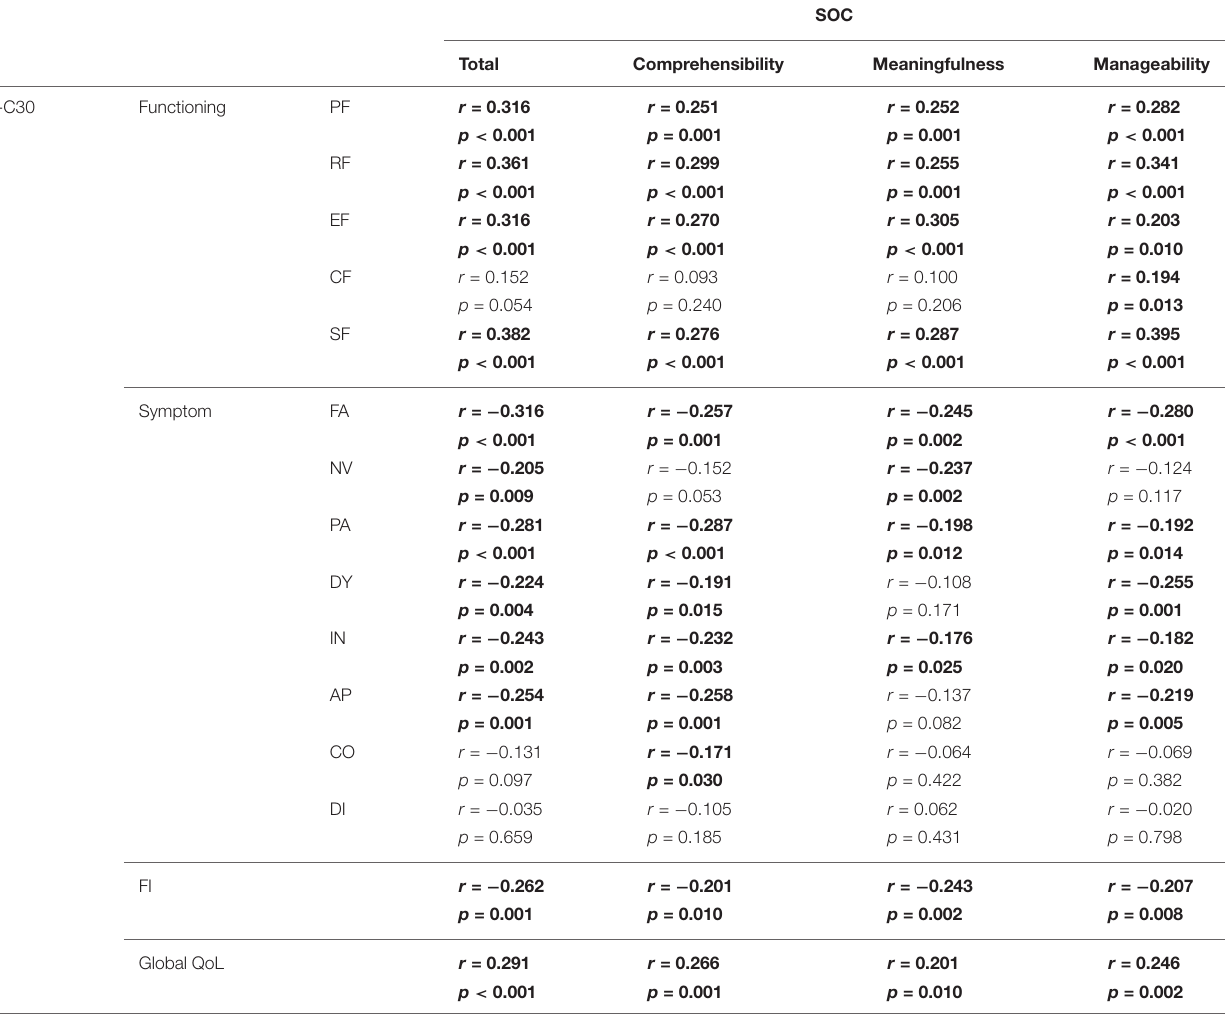
TABLE 3 | Correlations between SOC scores and HRQoL scores in patients with BM ( n = 162).